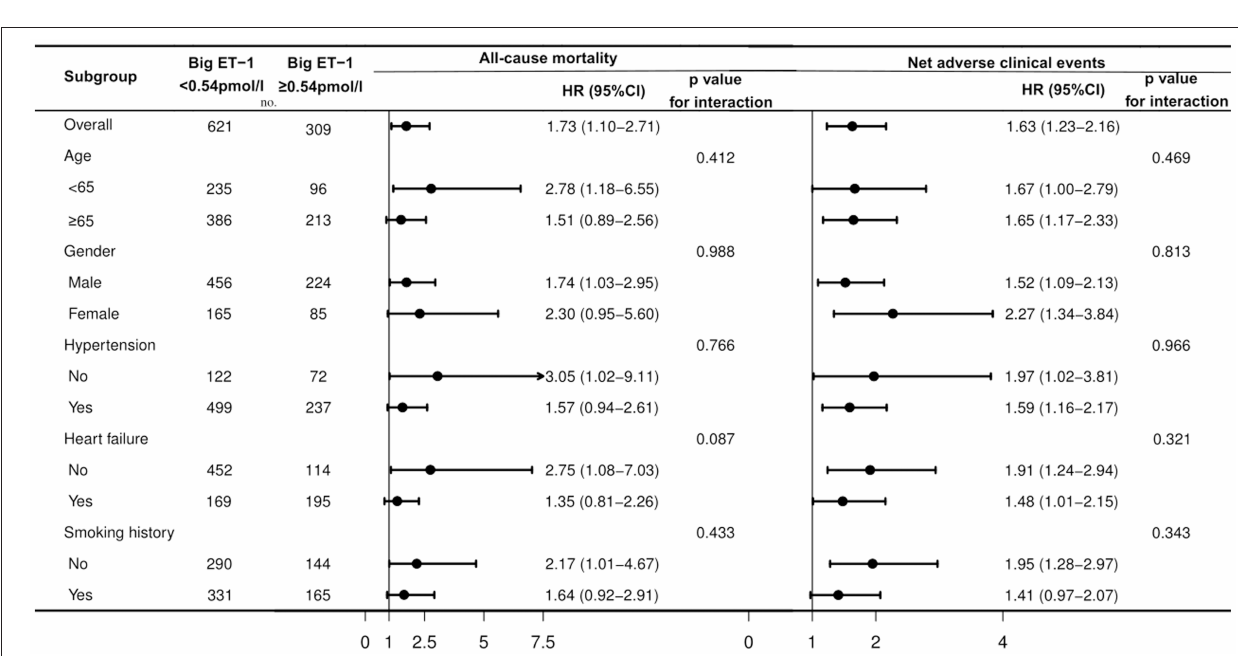
FIGURE 1 | The Kaplan–Meier survival curves in patients with AF and ACS or undergoing PCI divided by plasma big ET-1 levels: (A) cumulative survival, (B) survival free from net adverse clinical events. AF, atrial fibrillation; ACS, acute coronary syndrome; PCI, percutaneous coronary interventions; big ET-1, big endothelin-1.